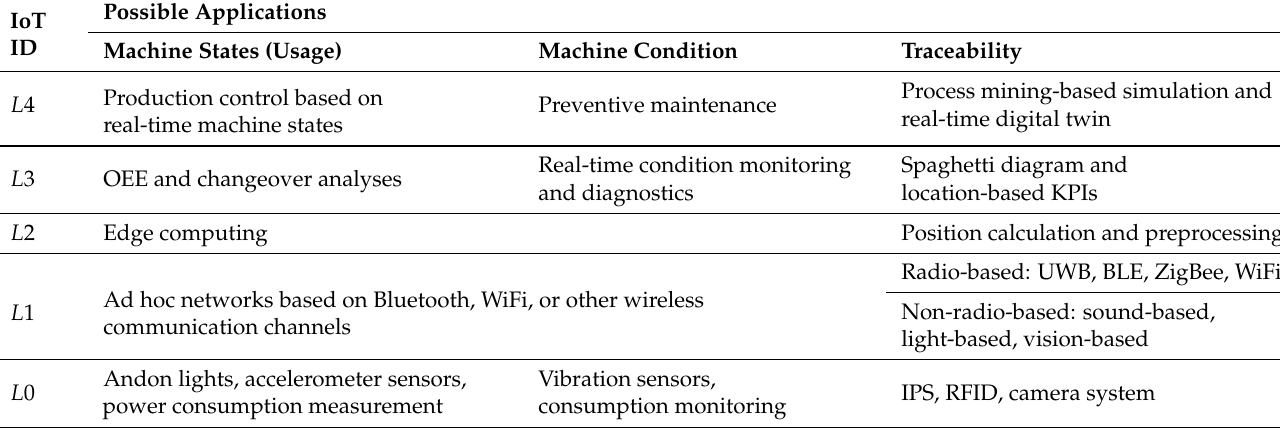
Table 1. The proposed applications for Industry 4.0 retrofitting and Operator 4.0 instructional materials based on IoT